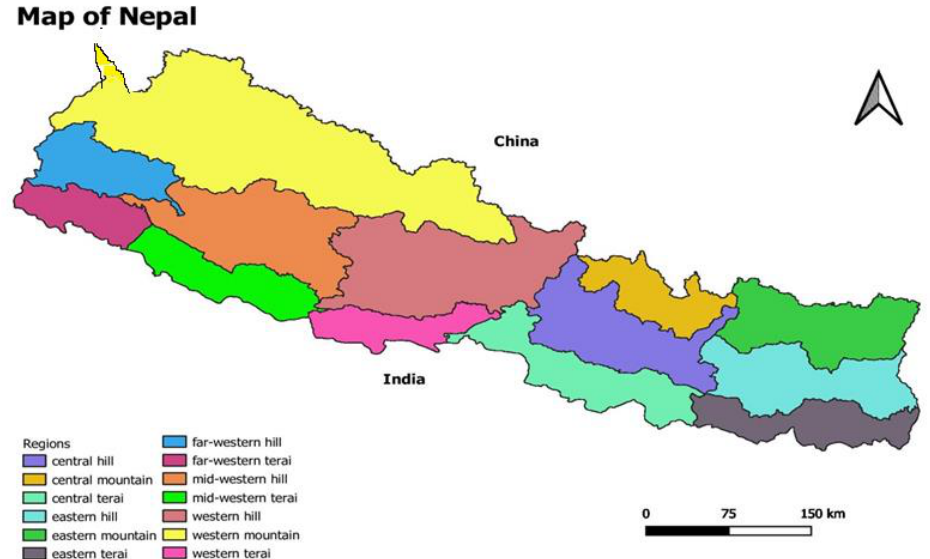
Figure 1. Eco-development region or cluster for study units.